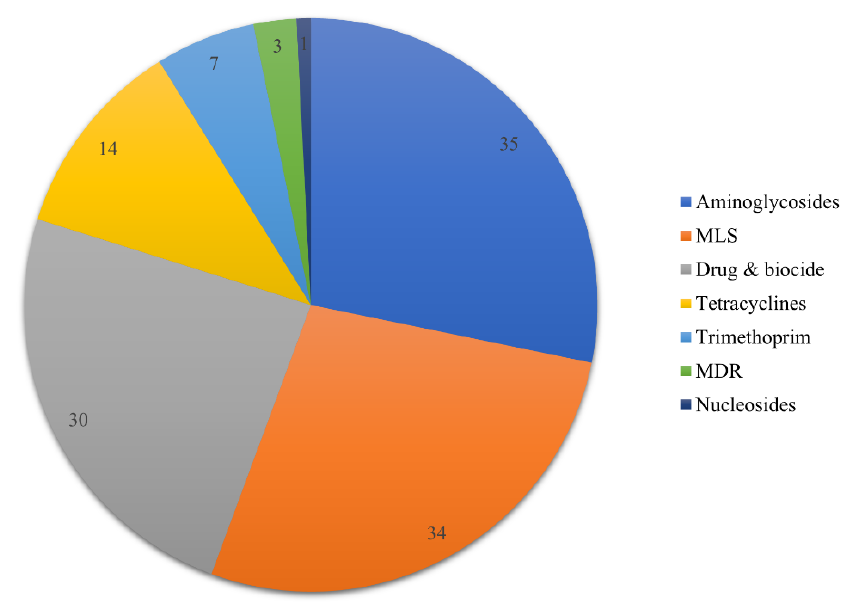
Figure 2. Distribution and number of AMR genes found in Enterococcus spp. per conferred antimicrobial class resistance.